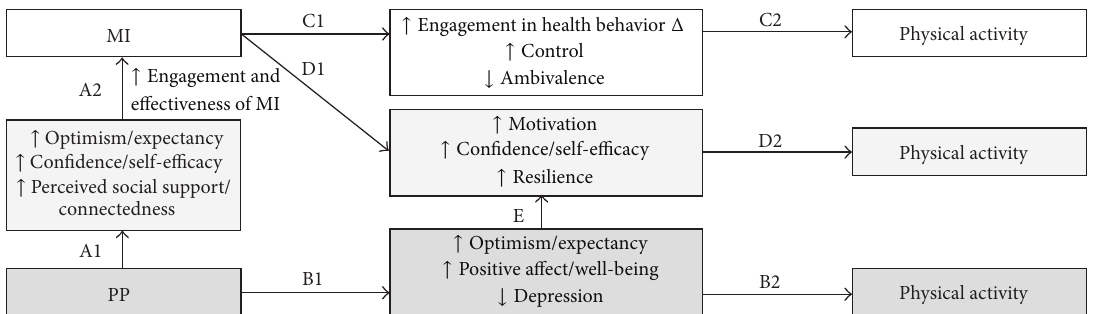
Figure 3: Conceptual model for the combination of positive psychology and motivational interviewing to improve physical